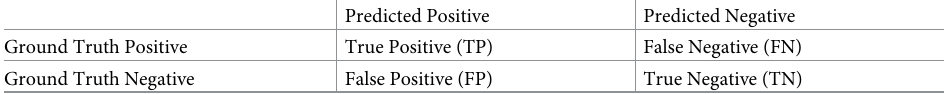
Table 1. Classic confusion matrix to visually analyze the classification performance of an